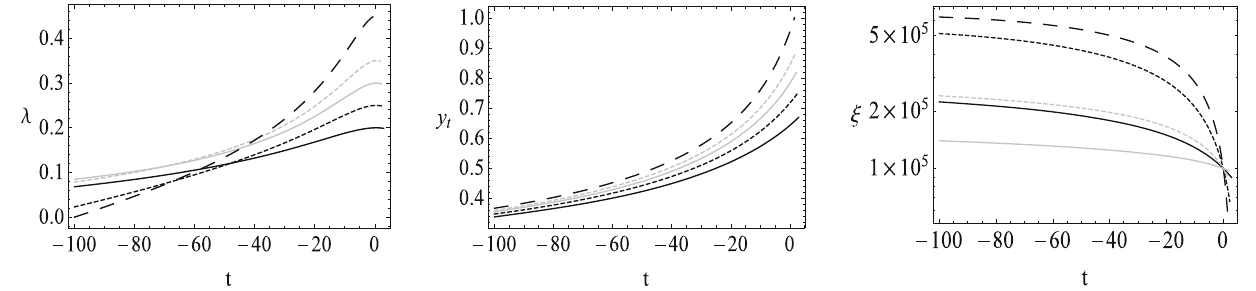
Fig. 9 The running of induced ln ( m 2 s /μ 2 ) and ln ( m 2 f 2 ∗ = 10 − 8 , λ ∗ = 0 . 1, ρ ∗ = 1 . 5 and (cid:2) = 10 − 16 . The flow is computed for five different values of ξ ∗ = 10 2 (black solid line), 10 3 (grey solid line), 10 4 (big dashed black line), 5 × 10 4 (big dashed grey line) and10 5